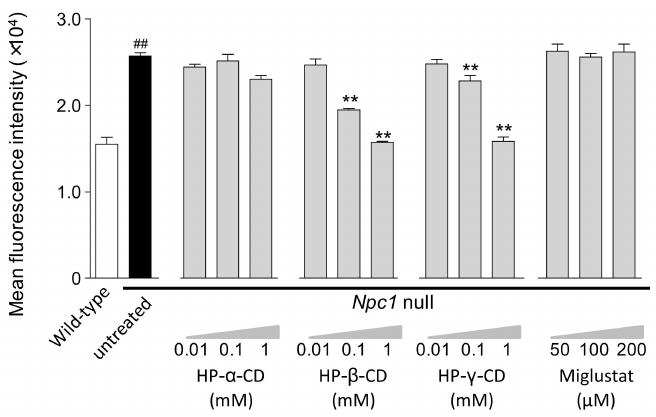
Figure 1. Concentration-dependent e ff ects of cyclodextrins (HP- α -CD, HP- β -CD, and HP- γ -CD) and miglustat on impaired lysosomal compartments in Npc1 -null CHO cells. The mean fluorescence intensity of LysoTracker ® was determined by flow cytometry at 24 h after exposure to cyclodextrins or miglustat. Each bar represents the mean ± S.E.M; ( n = 3), ## p < 0.01 compared with the wild-type (WT) group, ** p < 0.01 compared with the untreated Npc1 -null group.